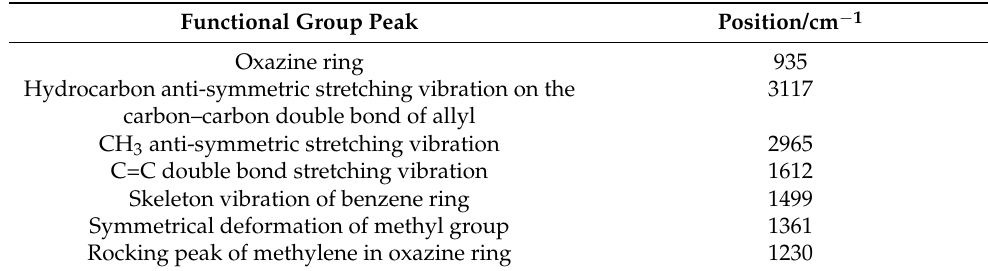
Figure 12. GPC of benzoxazine (bisphenol A) .